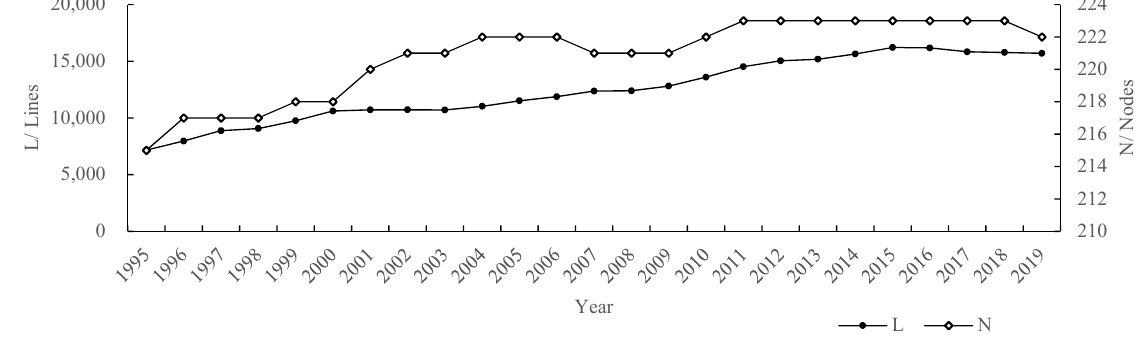
Figure 3. The numbers of lines and nodes of GNT from 1995 to 2019.